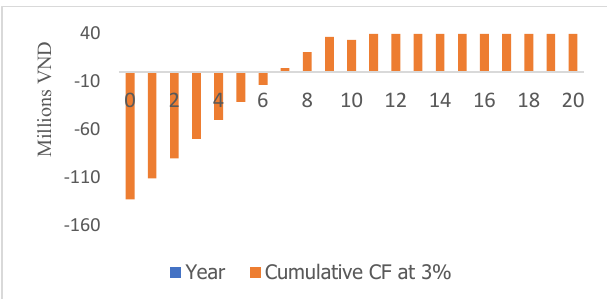
Table 7. Cumulative cash flow at discount rate of 11%